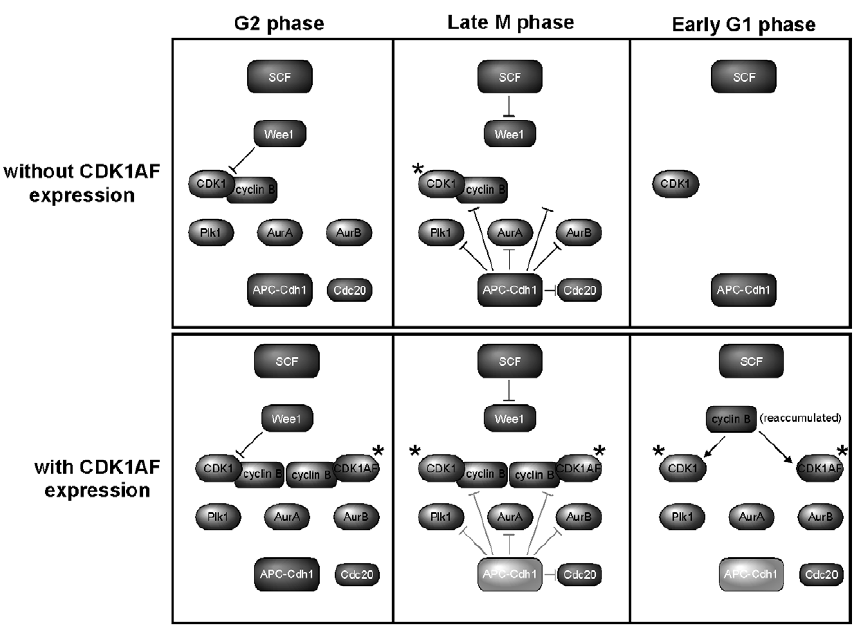
Figure 8. Overview of stabilized APC-Cdh1 targets and the absence of Wee1 in G1 daughters following division of cells with or without CDK1AF expression. Dark gray inhibitory symbols represent complete activation of APC-Cdh1; light gray inhibitory symbols (with CDK1AF expression) and light gray APC-Cdh1 represent a lack of sustained activation. Asterisks represent active CDK.